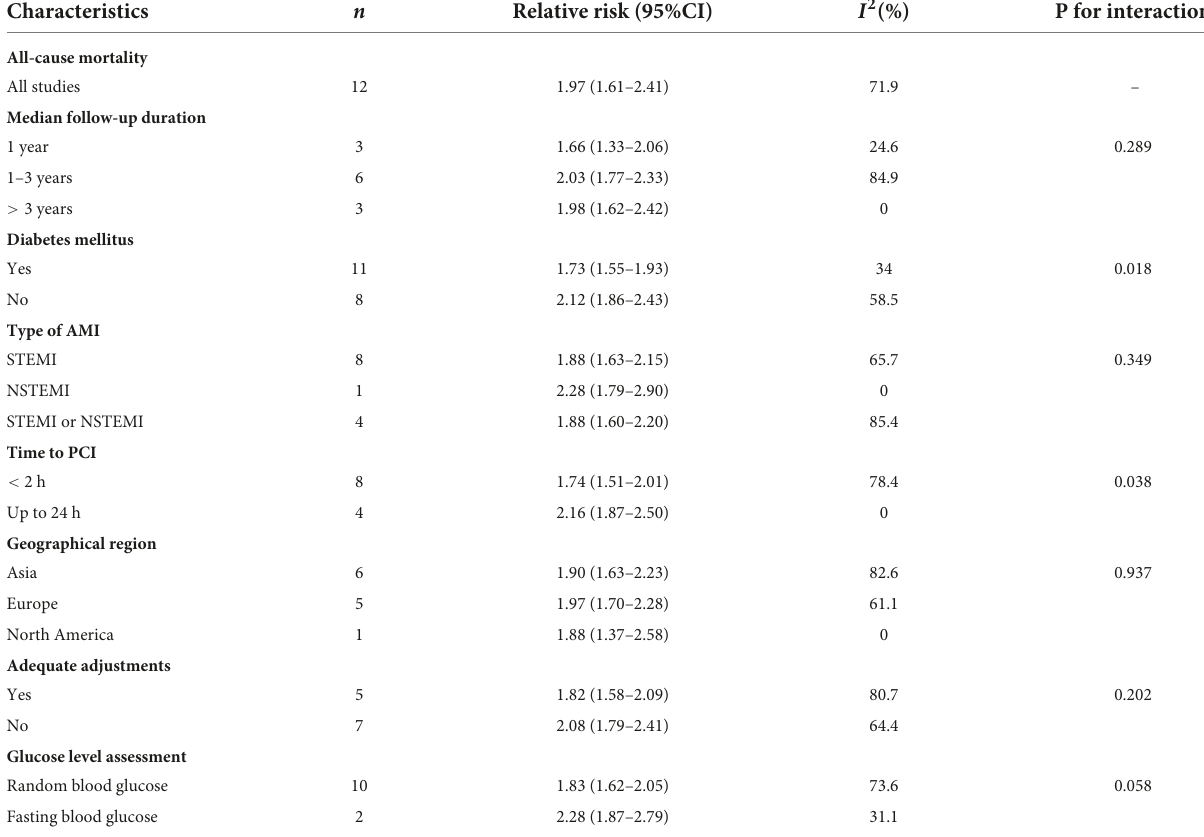
TABLE 2 Subgroup analysis of association between admission hyperglycemia and long-term outcomes in patients with AMI.